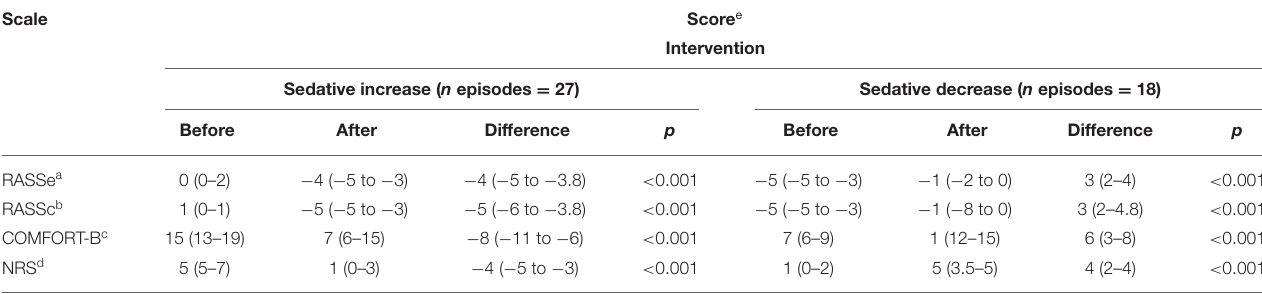
TABLE 5 | Median scores (IQR) of the 45 episodes assessed before and after an intervention of increase or decrease in sedatives. Scale